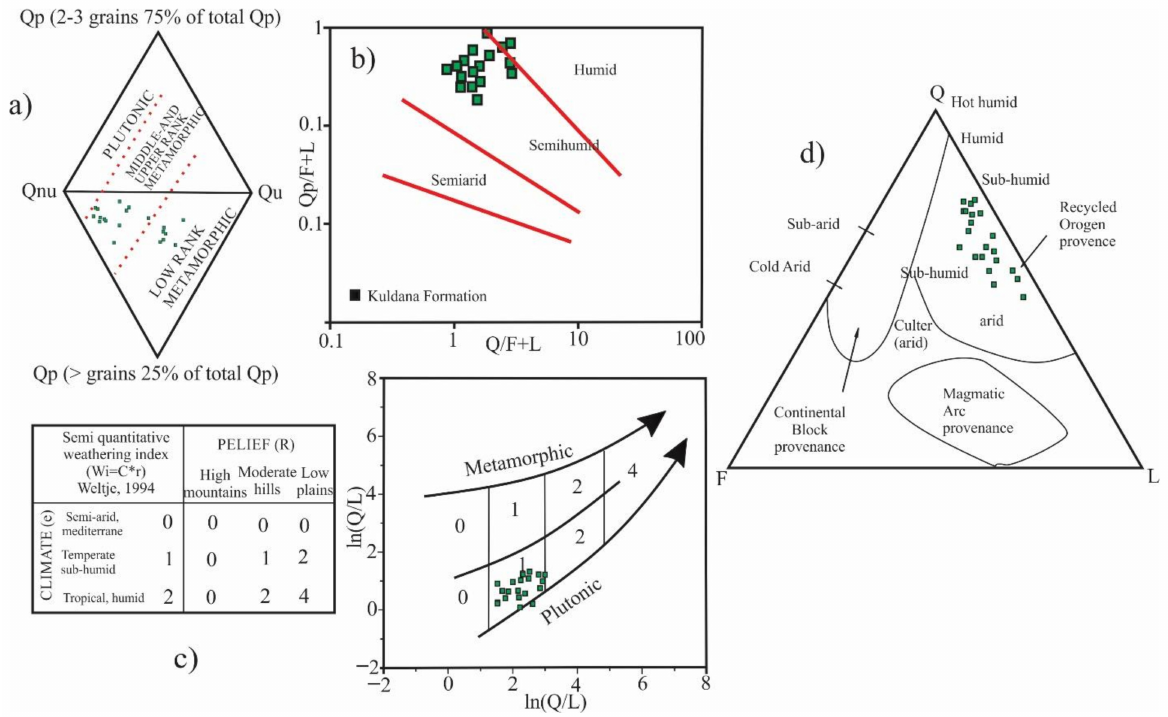
Figure 13. ( a ) A diamond diagram is shown for the interpretation of the Kuldana Formation’s provenance, ( b ) based on the Suttner and Dutta [86], plot of sandstone samples on the Q/(F + RF) vs. Qp/(F + RF), interpretation of the paleo-climatic conditions, ( c ) semi-quantitative weathering index and weathering diagram, ( d ) adapted from Suttner and Dutta [86], interpretation of ternary diagrams for sandstones in the Kuldana Formation (based on QFL ternary